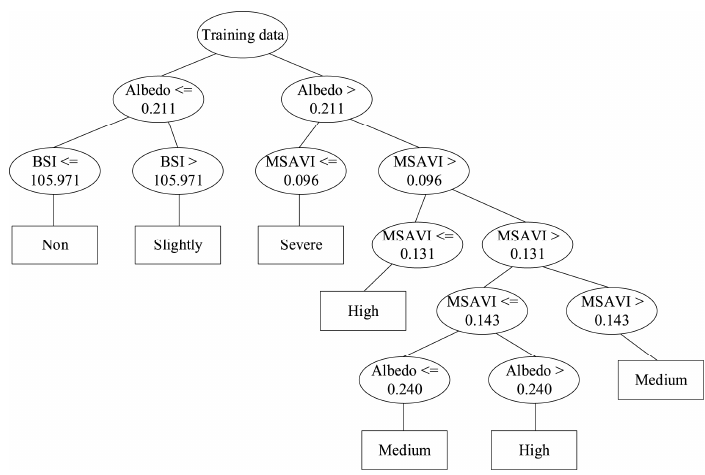
Figure 2. Statistically developed decision tree for the assessment of desertification status. MSAVI: modified soil adjusted vegetation index; BSI: bare soil index.